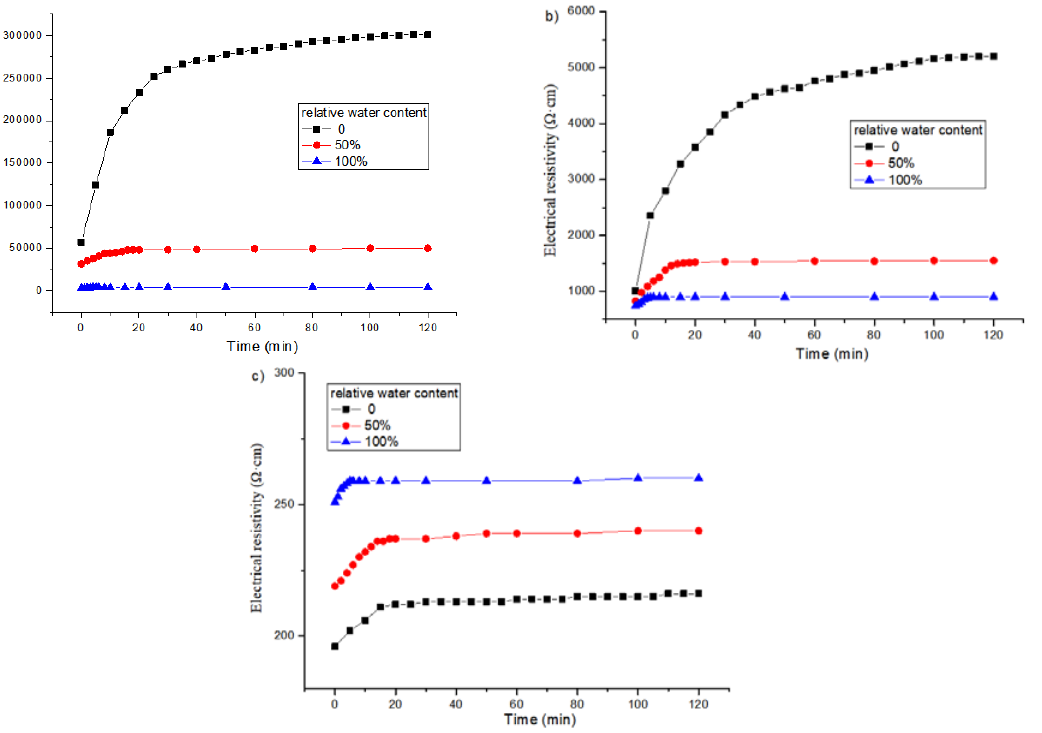
Figure 8. Influence of relative water content on polarization effect of specimens with different graphene content without freeze–thaw cycles: ( a ) 1%; ( b ) 2%; ( c ) 3%.